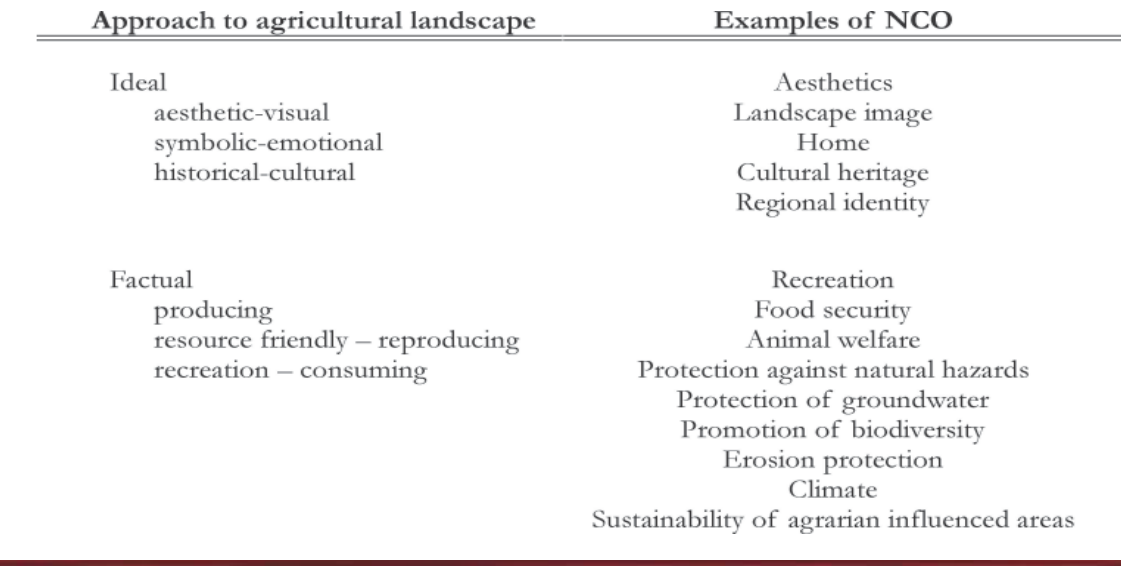
Table 2. Assignment of agricultural NCO to approach to agricultural landscape (Source: own